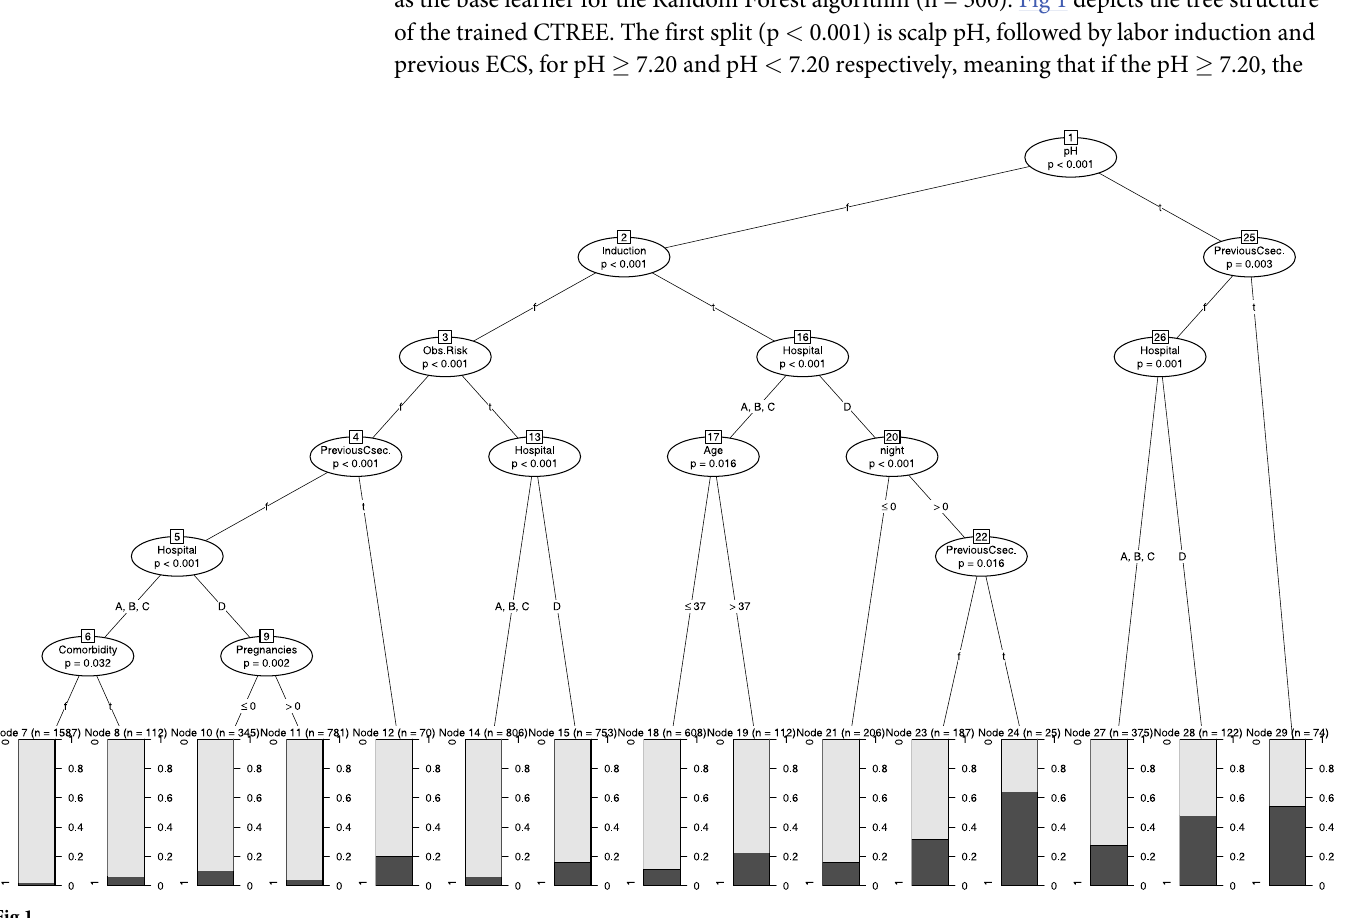
https://doi.org/10.1371/journal.pone.0191248.g001